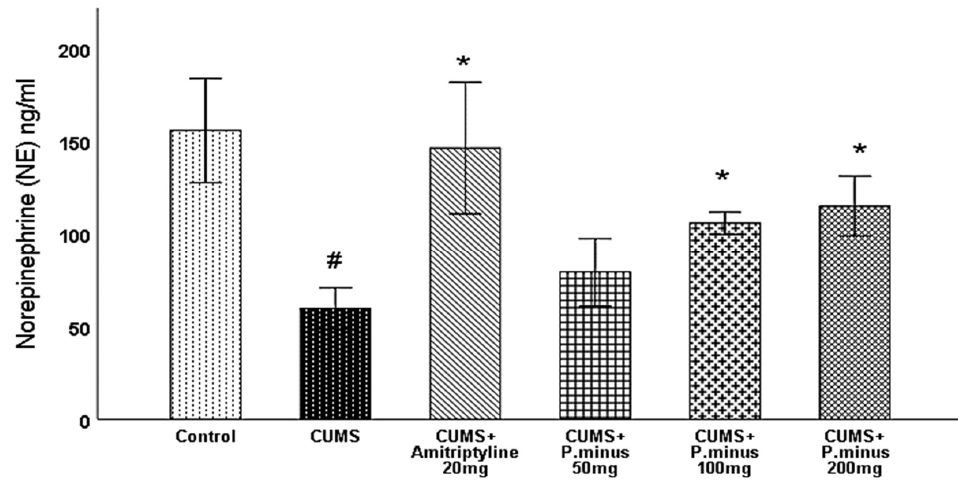
Figure 11. Effects of P. minus aqueous extract on Norepinephrine (NE) level(ng/mL) in CUMS induced depressive mice. # ( p < 0.05), vs. Control group; * ( p < 0.05), vs. CUMS group, ( n = 6).